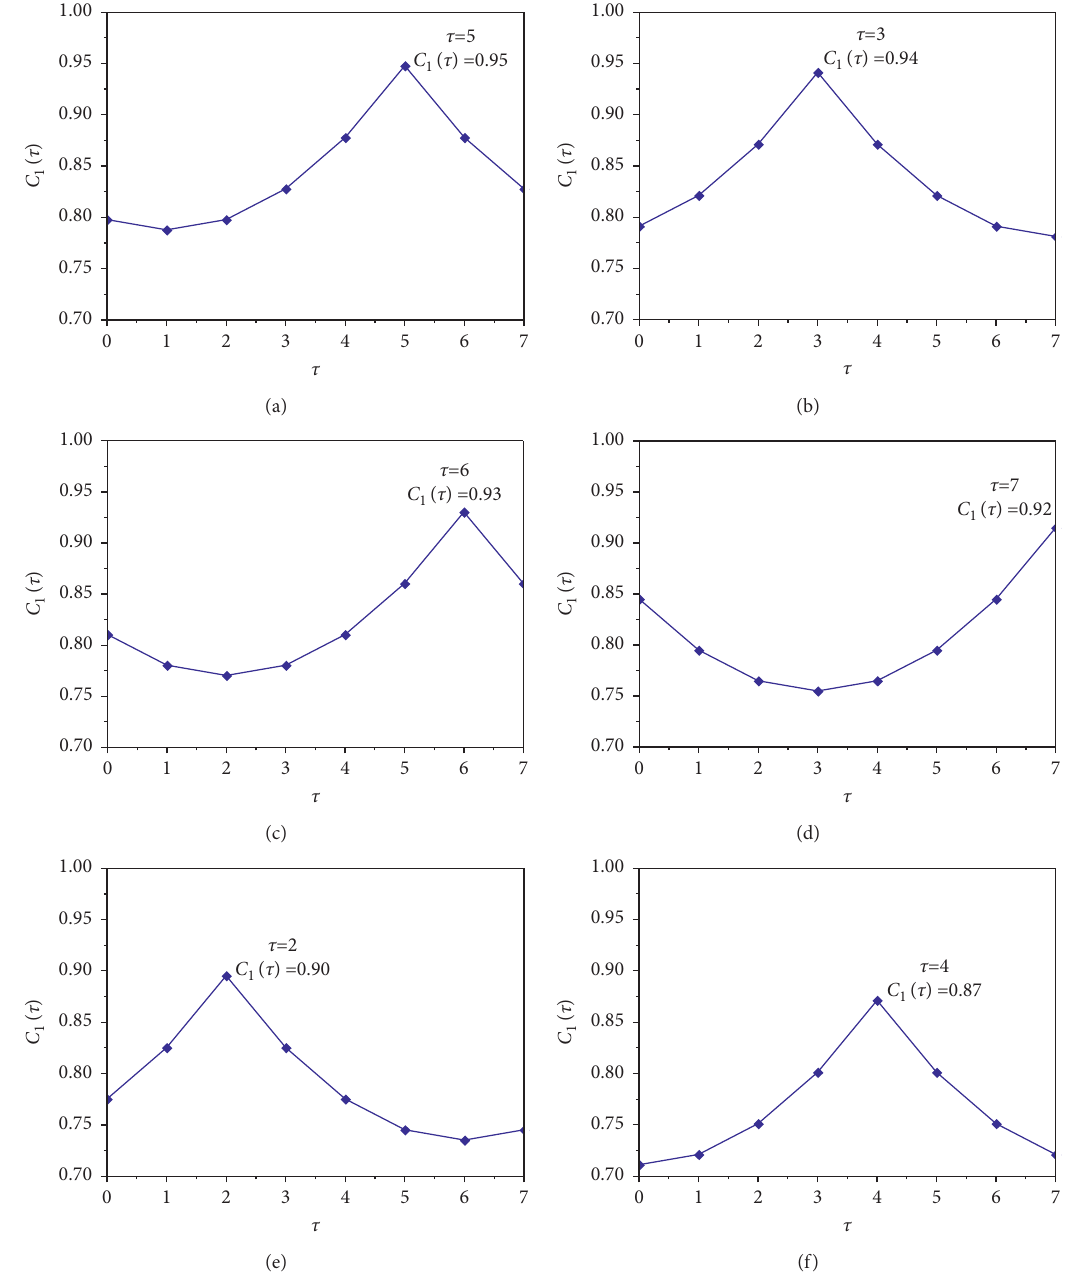
Figure 4: Correlation function calculation of various working conditions. (a) 1000r/min. (b) 2000r/min. (c) 3000r/min. (d) 4000r/min. (e) 5000r/min. (f) Table 2: Hypothetical value and identification value of blade serial number corresponding to the initial dynamic blade tip clearance pulse. Working condition 1000r/min Identification value